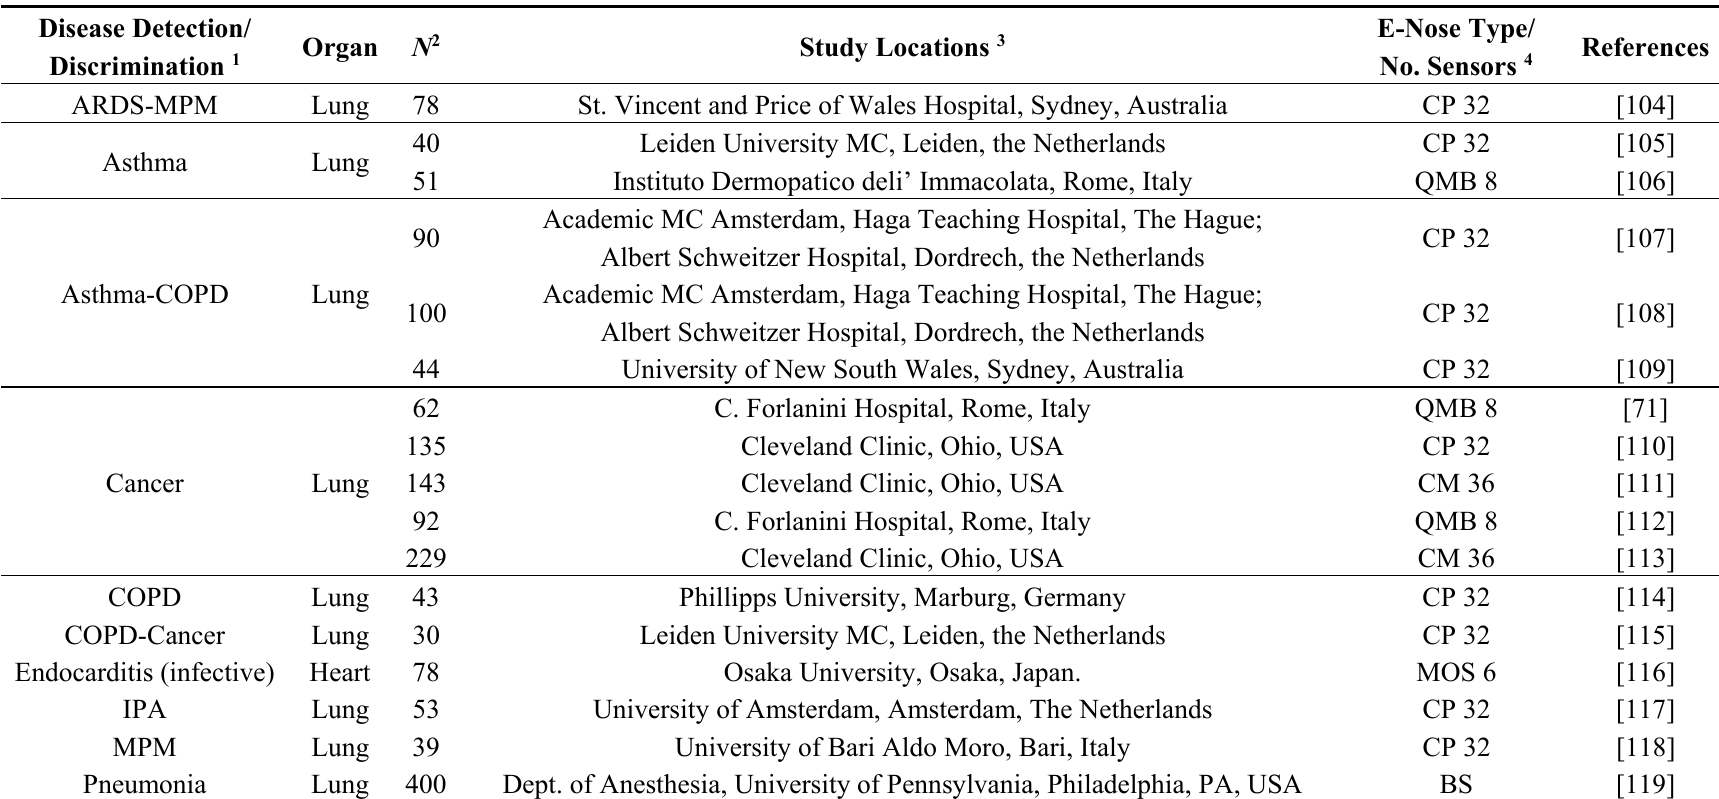
Table 3. Studies utilizing electronic-nose instruments to detect aroma profiles containing volatile biomarker compounds as indicators of disease in the human breath, exhaled breath condensate, bronchi, or alveolar